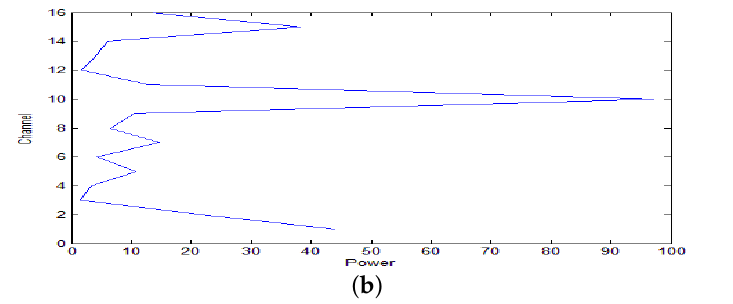
Figure 12. Time-reversal focusing of 9 kHz PCW signal transmitted by SRA2: ( a ) local amplification of the time-reversed signal received by the 10th channel of SRA2; ( b ) the energy distribution curve along the depth